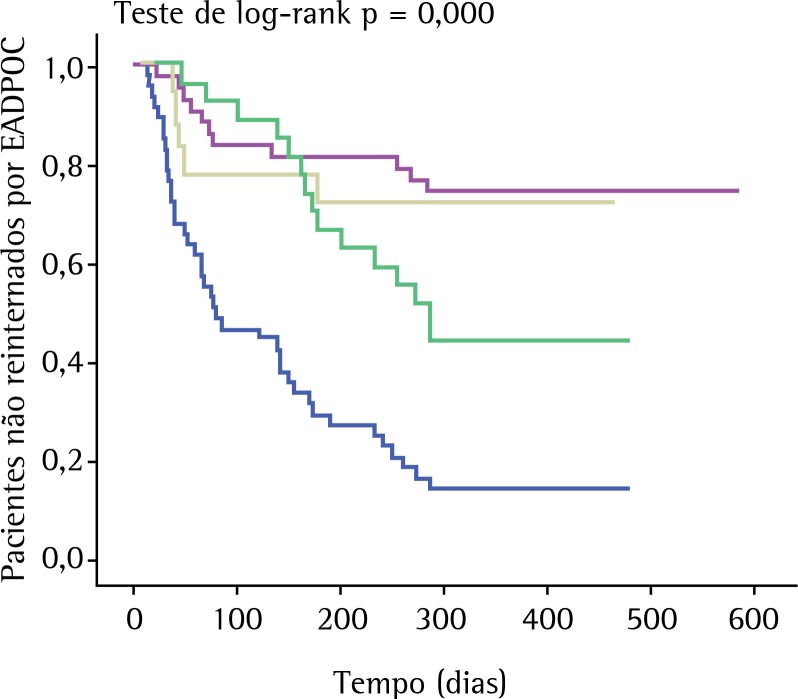
Curvas de Kaplan-Meier mostrando a reinternação por exacerbação aguda da
DPOC (EADPOC) durante o período de 12 meses de acompanhamento após a
primeira EADPOC. As curvas de reinternação são apresentadas para os quatro
subgrupos da coorte de pacientes, categorizados em função do nível sérico de
proteína C reativa de alta sensibilidade (PCRas) no momento da alta e da
categoria de risco da Global Initiative for Chronic Obstructive Lung Disease
(GOLD). A ordem dos grupos, da maior para a menor taxa de reinternação (p
< 0,001), foi a seguinte: PCRas sérica = 3 mg/L e categoria GOLD D; PCRas
sérica = 3 mg/L e categoria GOLD A-C; PCRas sérica < 3 mg/L e categoria
GOLD D; PCRas sérica < 3 mg/L e categoria GOLD A-C.